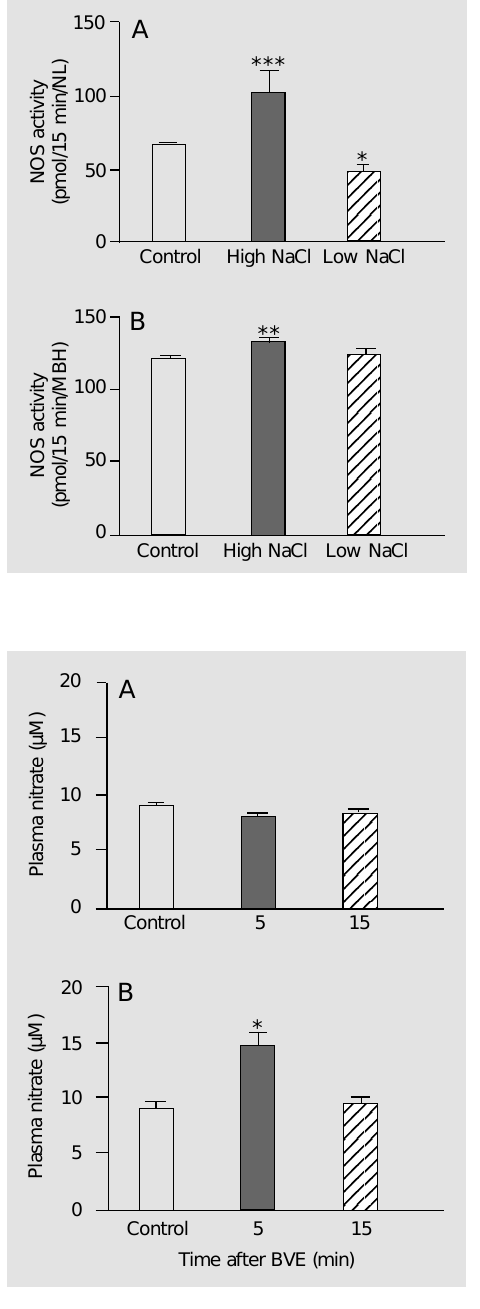
Figure 1. Effect of a chronic (7 days) high or low NaCl diet on nitric oxide synthase (NOS) ac- tivity in the neural lobe (NL) (A) and medial basal hypothalamus (MBH) (B) of adult male rats. Data are reported as means ± SEM for 7-10 rats. *P<0.05, **P<0.01 and ***P<0.001 com- pared to control rats under regu- lar NaCl diet (Student t